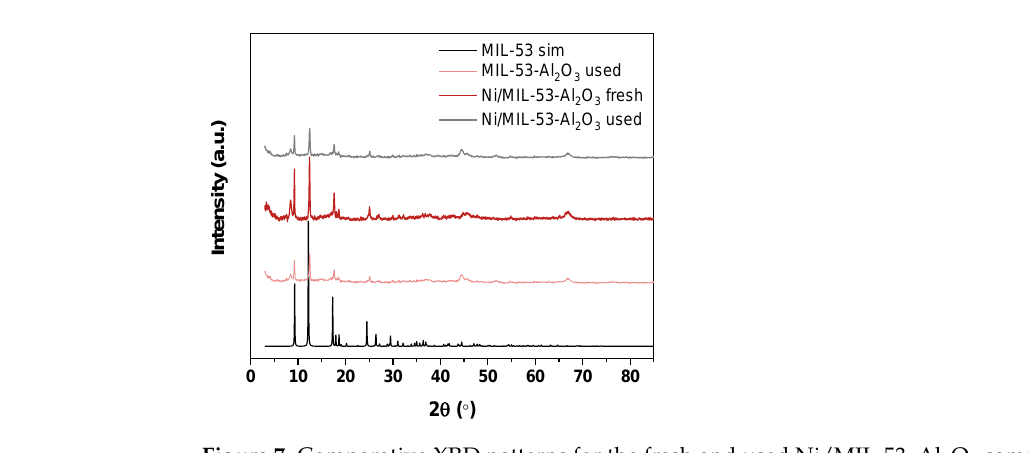
Figure 7. Comparative XRD patterns for the fresh and used Ni/MIL-53–Al 2 O 3 samples.